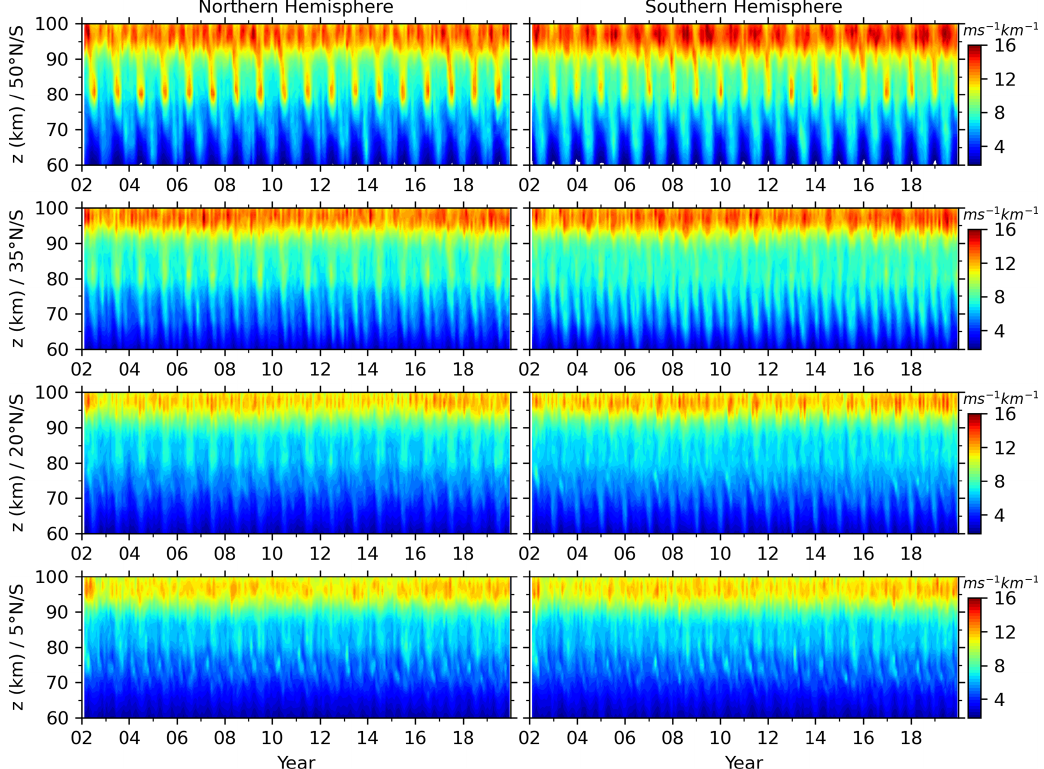
Figure 9. Time–height contours of the monthly zonal-mean GW-perturbed shears ( S ) at four latitudes (50 ◦ , 35 ◦ , 20 ◦ , and 5 ◦ N and S, see the y -axis label of each row) of the NH (left column) and SH (right column) from 2002 to 2019. All panels have the same color scales with unit of ms − 1 km − 1 . All panels have the same x -axis and y -axis scales.